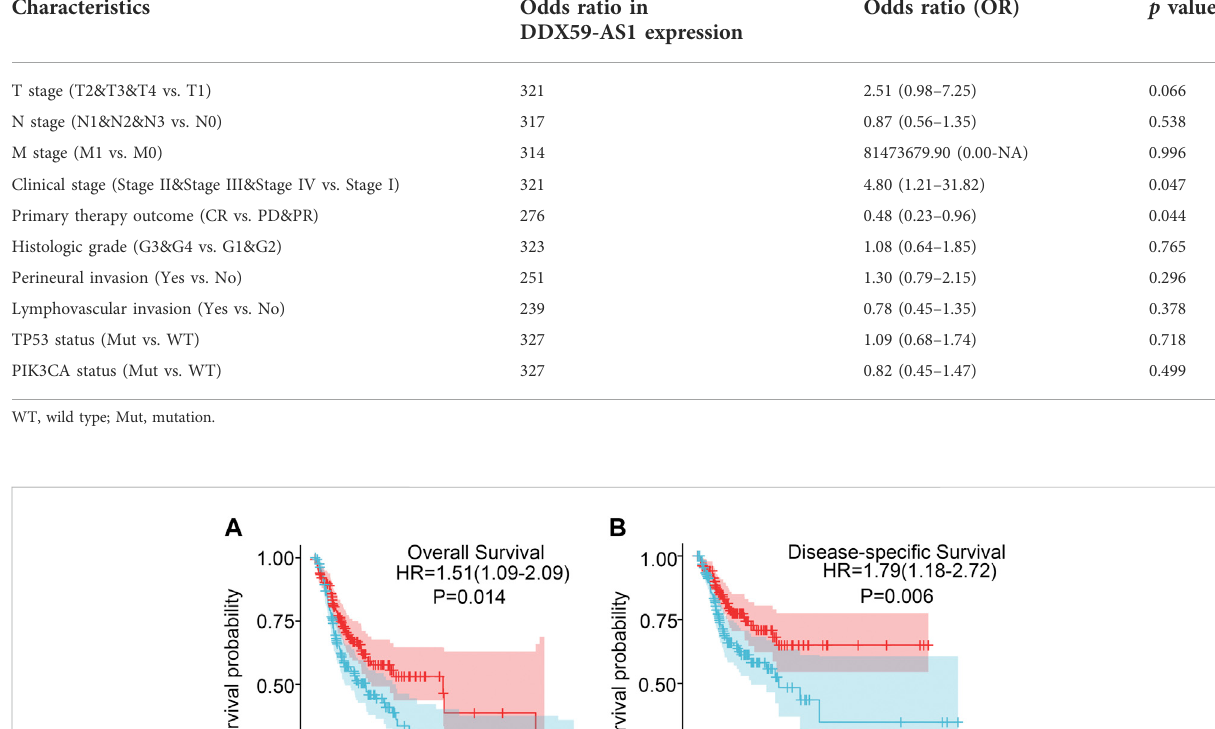
TABLE 2 Logistic regression analysis of association between clinicopathological characteristics and DDX59-AS1 expression in OSCC patients. Characteristics